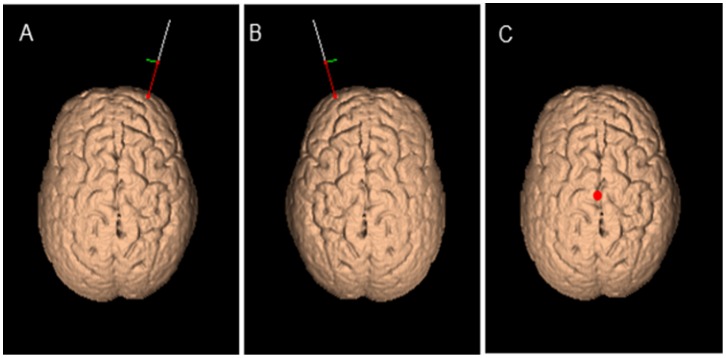
Coil positions for cTBS stimulation.The coil positions for Right BA 10 (MNI coordinates: x = 30.3±3.6; y = 50.9±3.8; z = 13.6±2.7; A) Left BA 10 (MNI coordinates: x = –30.3±3.4; y = 50.9±2.8; z = 13.6±1.9; B) and Cz (MNI coordinates: x = 0±3.8; y = 0±2.7; z = 94±4.1; C) are here illustrated. The sites of stimulation were defined by using Softaxic neuronavigation system.